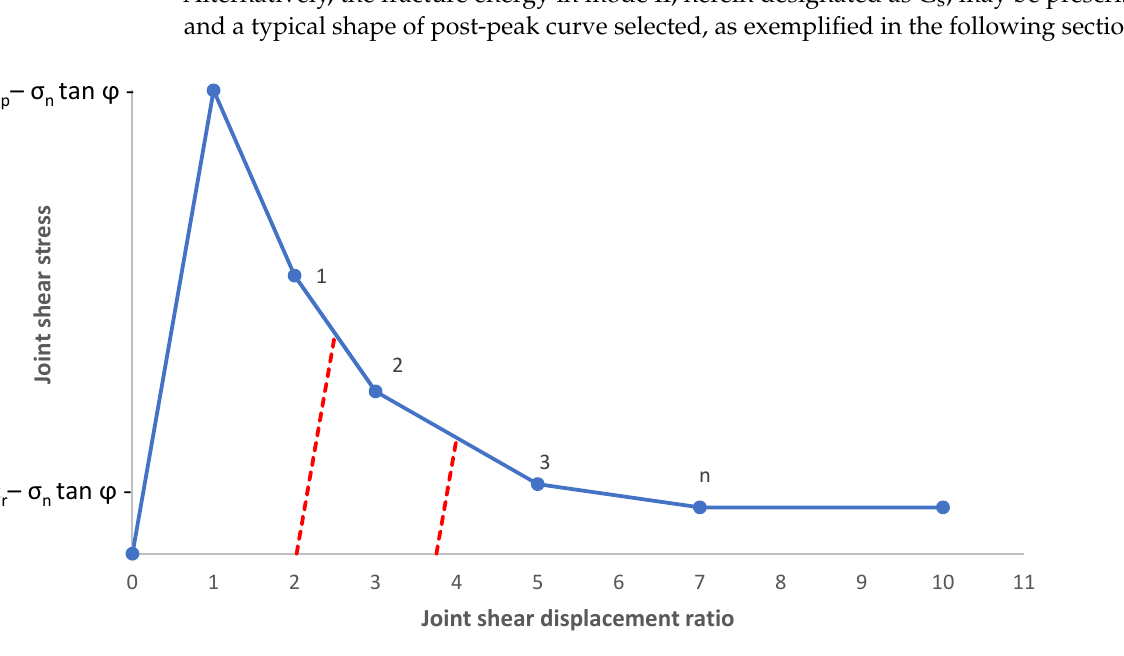
Figure 5. Shear behavior. Joint cohesive strength ratio vs. joint shear displacement ratio.